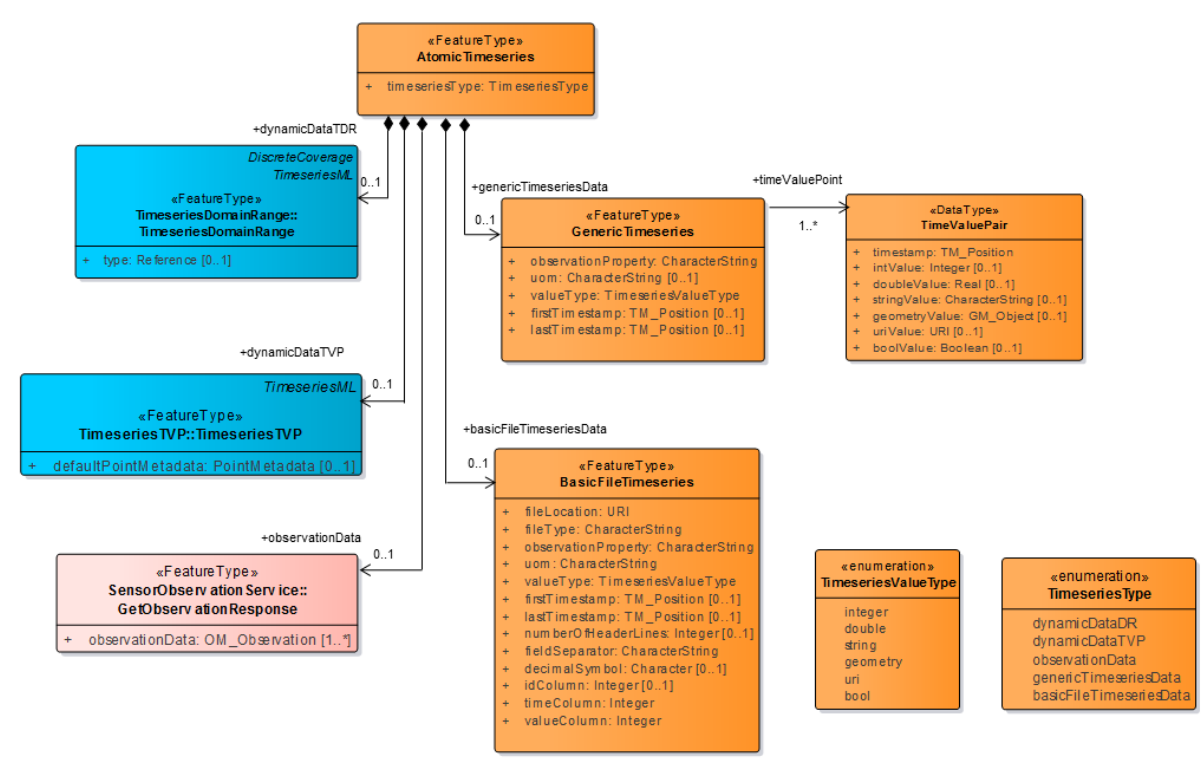
Figure 1. Modified UML Model of the Dynamizer ADE. The AtomicTimeseries includes two new classes: GenericTimeseries and BasicFileTimeseries. The other classes are shown in (Chaturvedi, Kolbe,